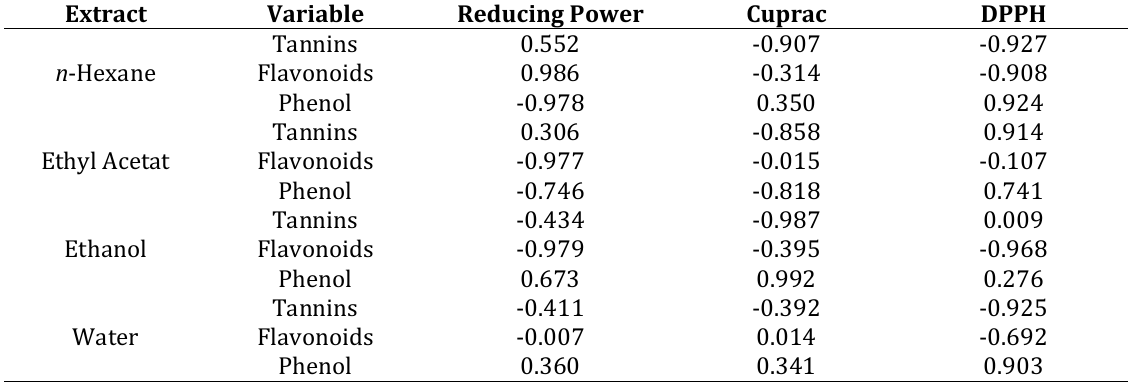
Table III. Pearson correlation phenolic, flavonoids, tannin content and antioxidant activity.